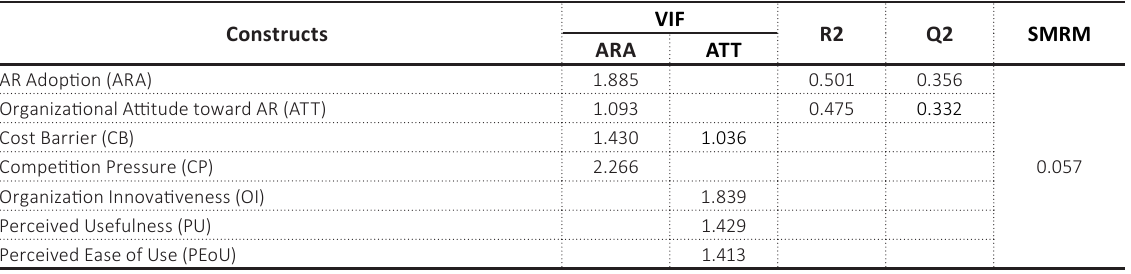
Table 3. R 2 , Q 2 , and SMRM